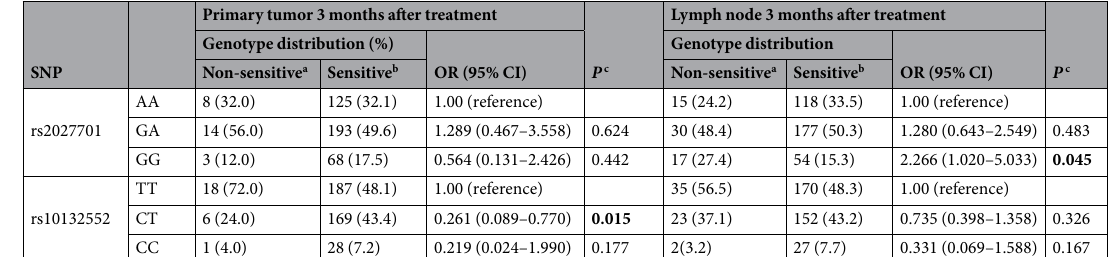
Table 5. Association between rs2027701 and rs10132552 and the efficacy of CRT at the primary tumor and lymph node 3 months after treatment in NPC patients a Complete response (CR) and partial response (PR). b Stable disease (SD) and progressive disease (PD). c Adjusted for age, sex, BMI, smoking status, drinking status, histological type, clinical stage, T-staging, N-staging, induction chemotherapy regimens, concurrent chemoradiotherapy regimen, irradiation dose for the association between SNPs and the efficacy of CRT at the primary tumor and lymph node 3 months after treatment. Abbreviations: OR, odds ratio; CI, confidence interval. P value < 0.05 is shown in